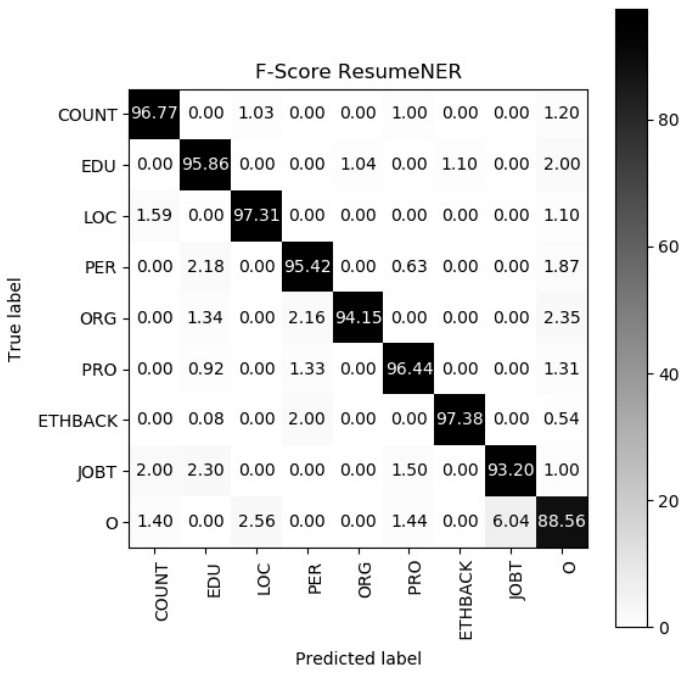
Figure 4. A classification result of the various named entities in ResumeNER.